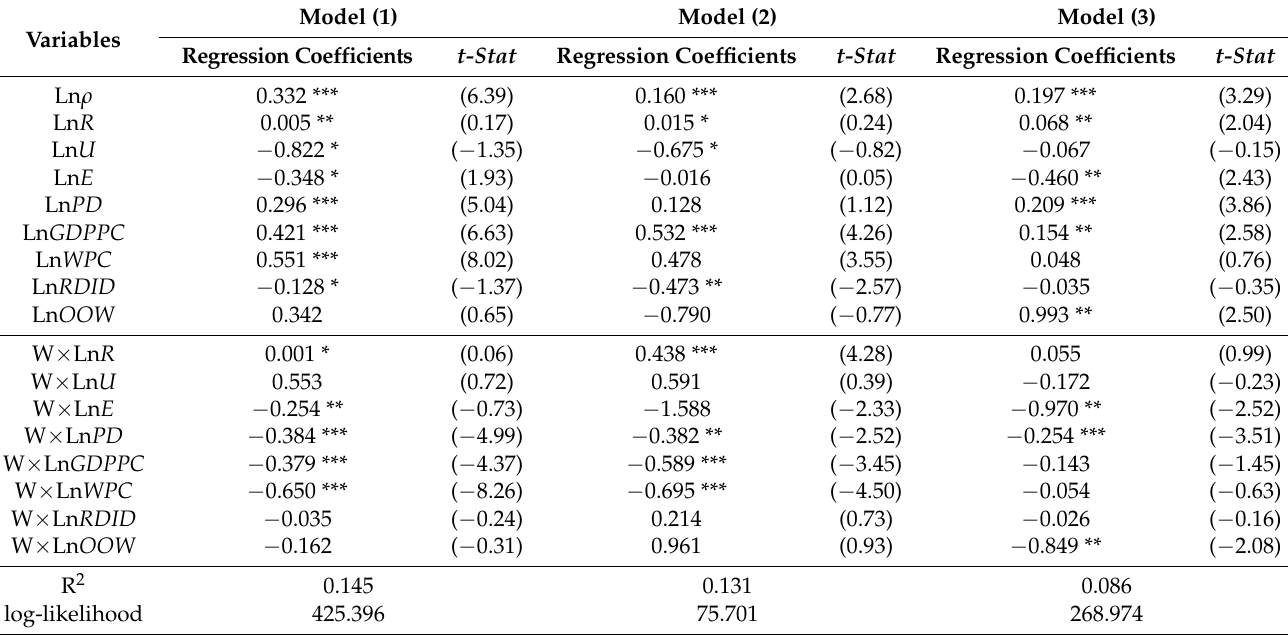
Table 2. The estimation results of spatial Durbin